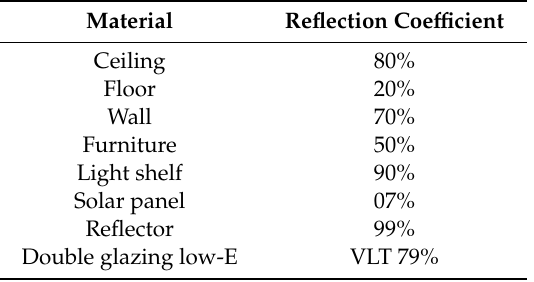
Figure 5. ( a ) Plan view representation of the grid points, illuminance sensors and lighting positions, ( b ) light distribution of conical illuminance. Table 5. Material reflection coe ffi cient